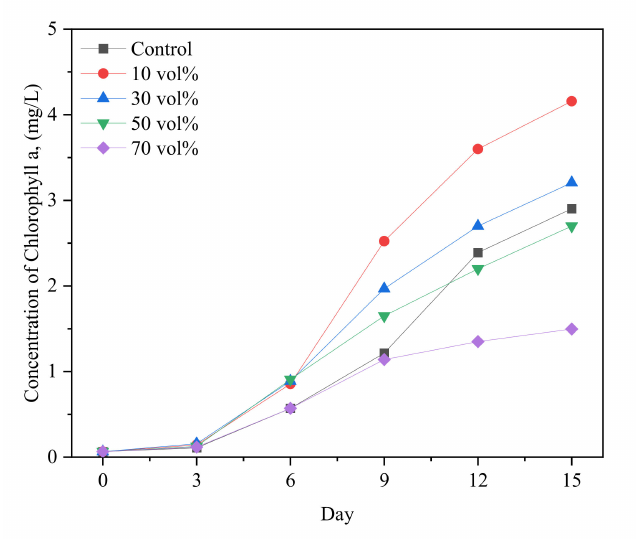
Figure 2. Effects of various additions (vol%) of converter slag leaching solution on concentration of chlorophyll a (mg/L).